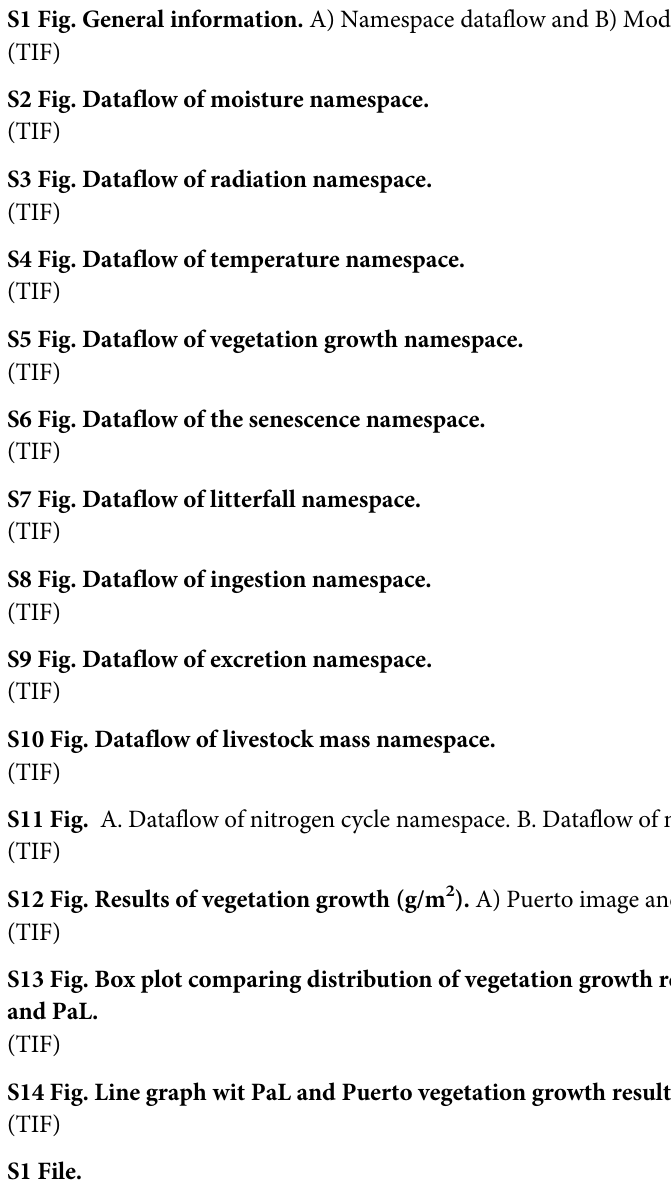
S4 Fig. Dataflow of temperature namespace. S5 Fig. Dataflow of vegetation growth namespace. S6 Fig. Dataflow of the senescence namespace. S7 Fig. Dataflow of litterfall namespace. S8 Fig. Dataflow of ingestion namespace. S9 Fig. Dataflow of excretion namespace.